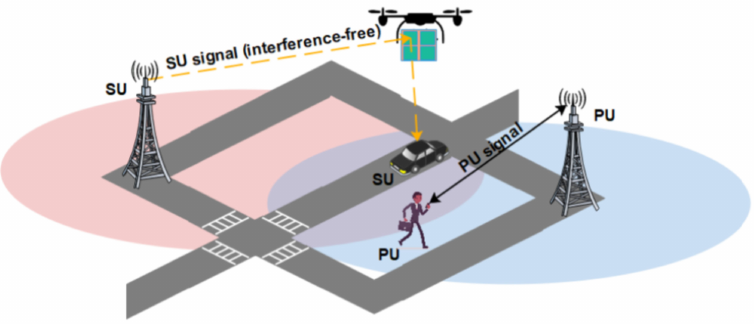
Figure 11. IRS-assisted UAV for spectrum sharing [23].